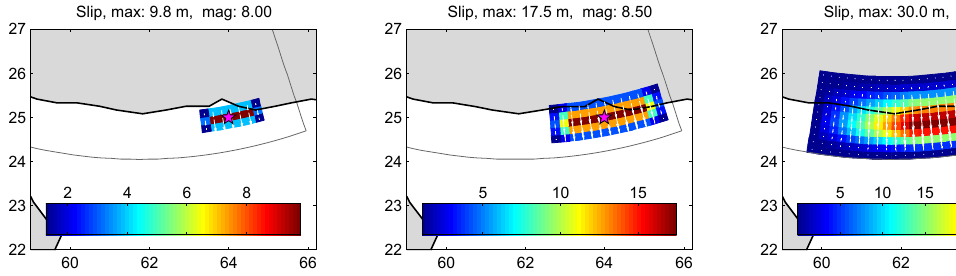
Figure C1. Illustration of the empirical scaling relations and slip distribution.